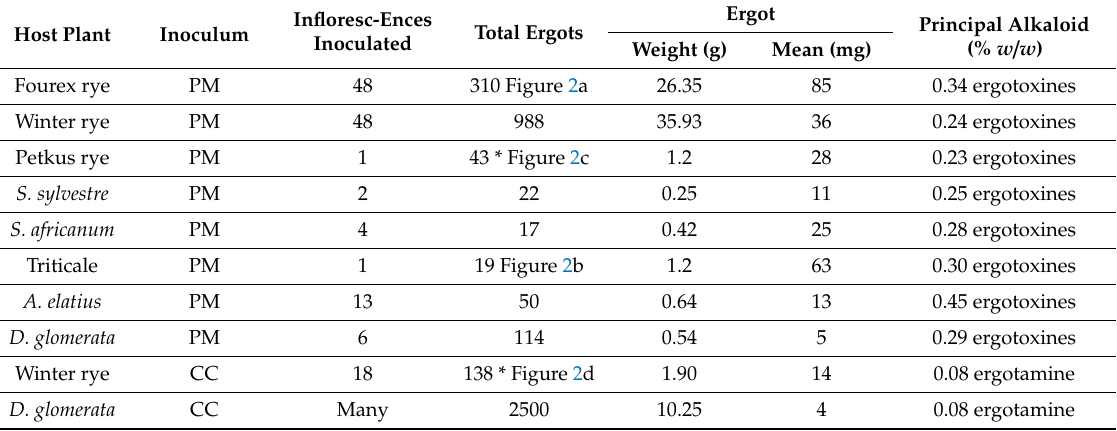
Table 1. Parasitic performance of C. purpurea from D. glomerata in potential rye and grass host inflorescences. Influence of inoculum (Scheme 1, sourced via plectenchyma selection) from honeydew resident on sclerotia from rye (PM). For contrast outcome in sclerotial yield and alkaloid content, conidia-rich white non-plectenchymatic axenically-cultured mycelium (CC) was obtained directly from the original wild ergots.